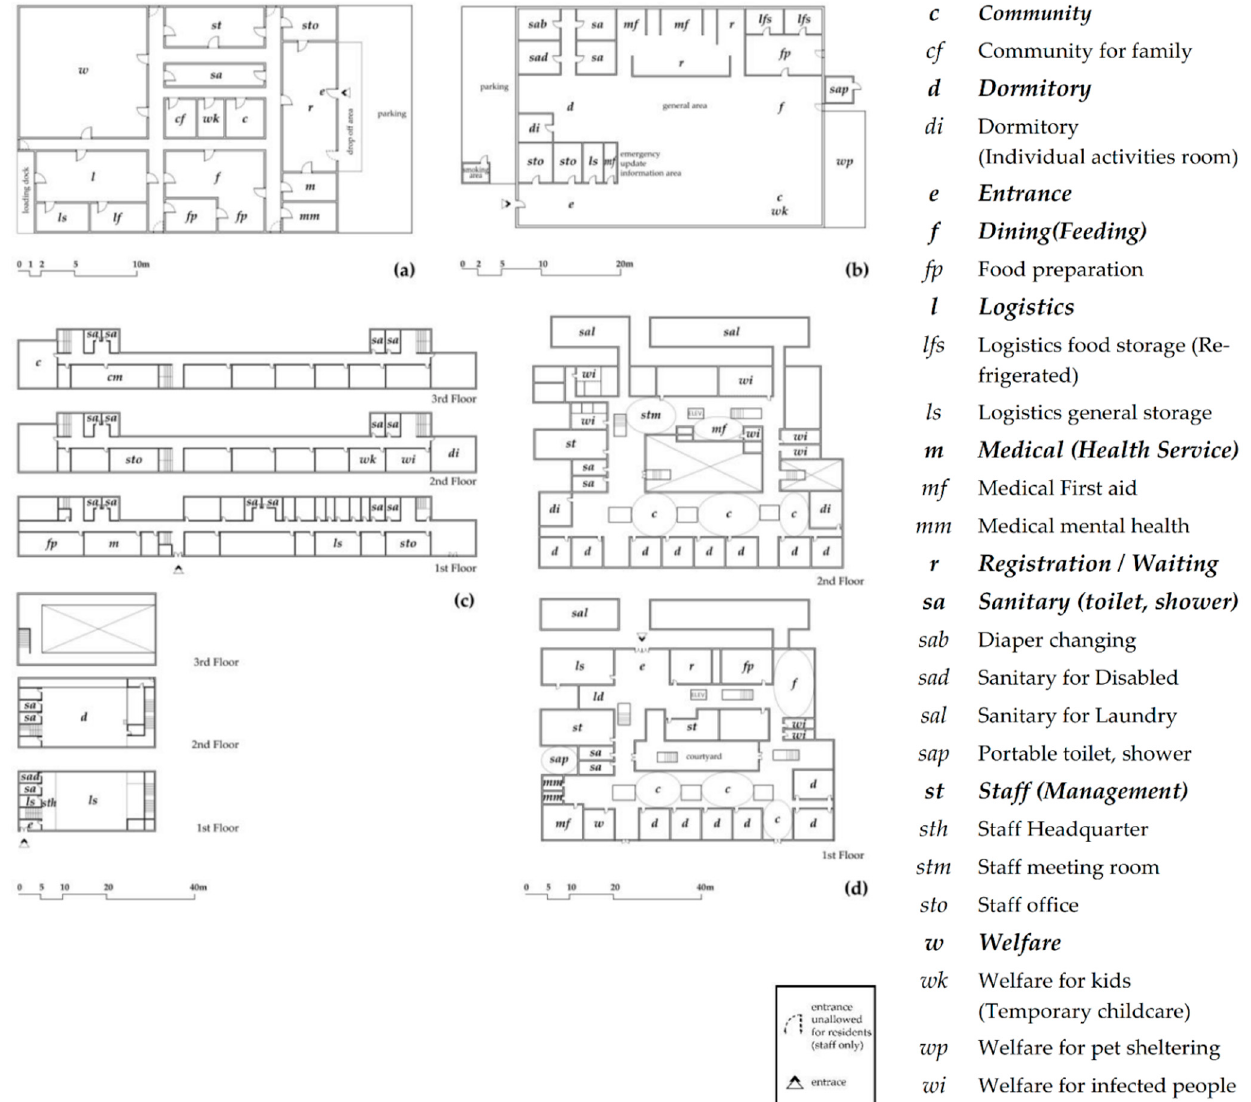
Figure 2. Mega-shelter floor plan: ( a ) case 1 (U.S.); ( b ) case 2 (AU); ( c ) case 3 (JP1); ( d ) case 4